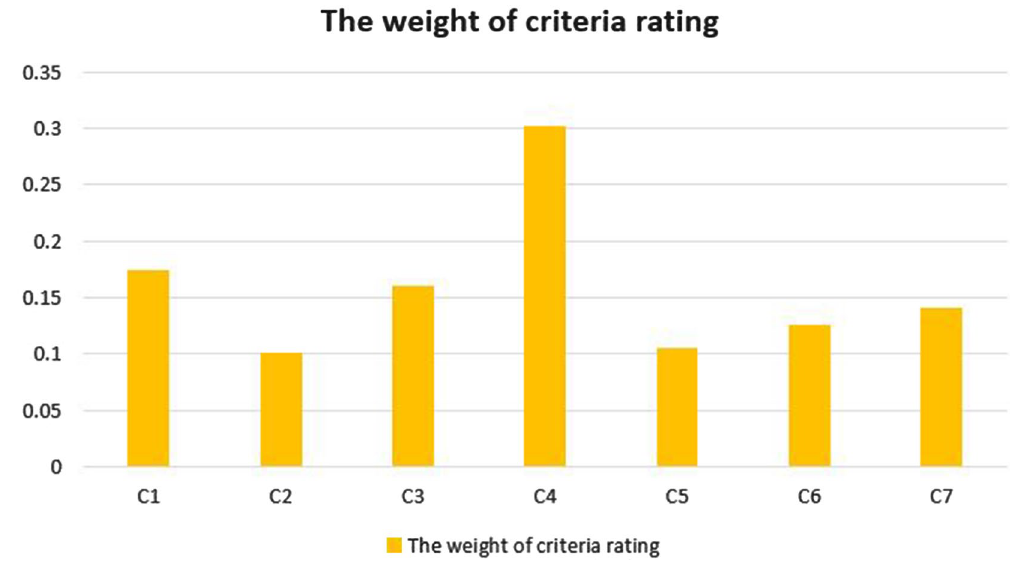
Fig. 4 The weight of criteria